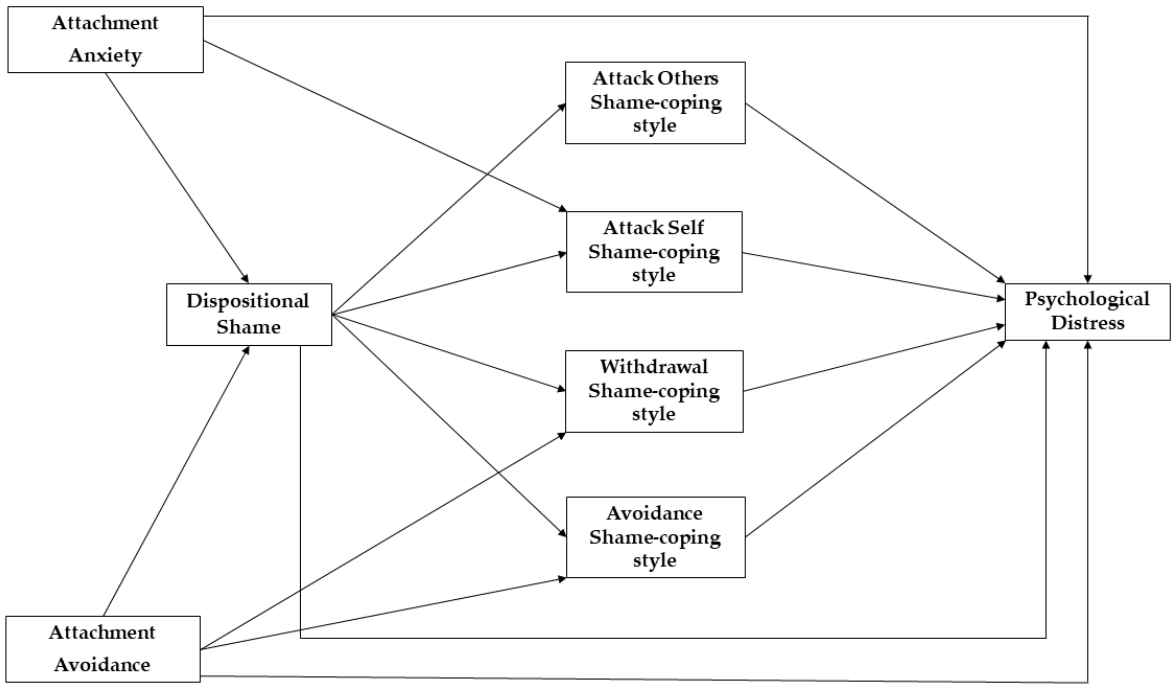
Figure 1. Hypothesized serial mediation model. All hypothesized associations are positive.